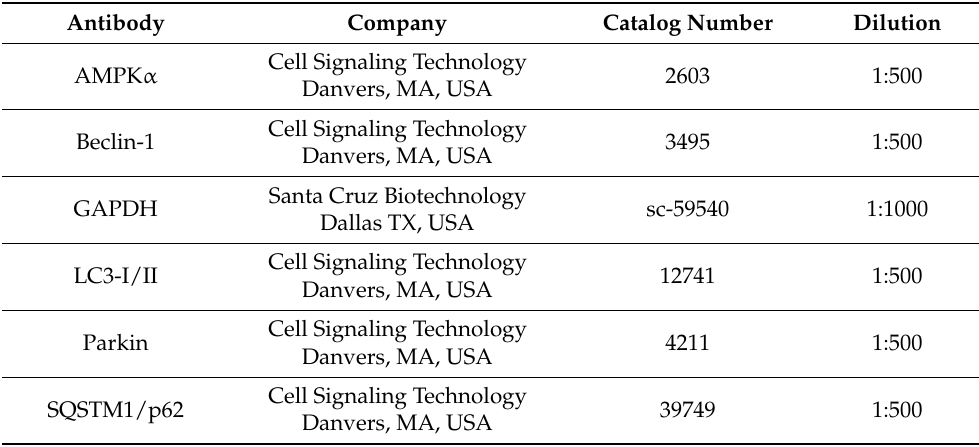
Table 3. List of primary antibodies used for western